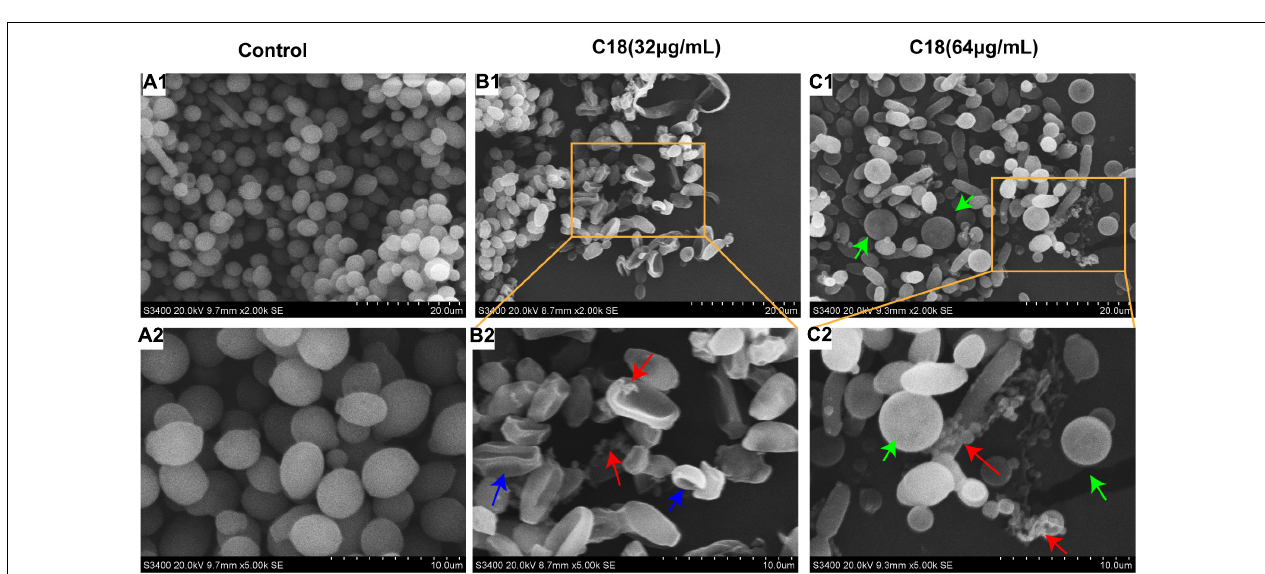
FIGURE 5 | Scanning electron microscopic (SEM) images of Candida albicans in the absence and presence of C18 at 35 ◦ C for 3 h. (A1-A2) SEM images of C. albicans treated without C18. (B1-B2) SEM images of C. albicans treated with 32 µ g/ml of C18. (C1-C2) SEM images of C. albicans treated with 64 µ g/ml of C18. Red arrow indicates the cell wall and membrane was destroyed leading to intracellular component leaked away. Blue arrow indicated the surface was folded and depression occurred in the cells. Green arrow indicated the size of cells was different and many cells were